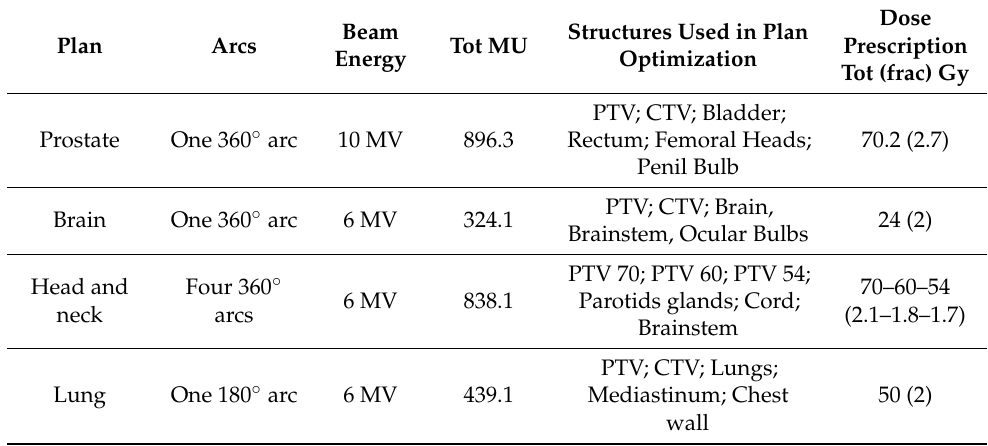
Figure 2. The Alderson phantom with the applied contours used for planning. Table 1. Parameters used for planning the volumetric modulated treatment with the radiobiological cost functions of MONACO 5.11.